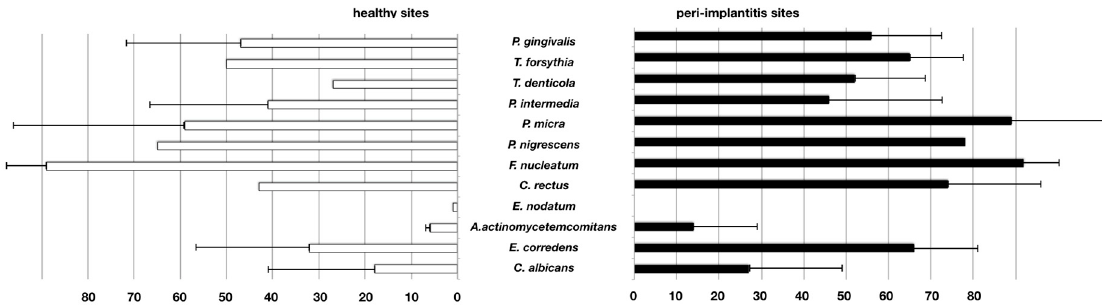
Figure 3. Frequency of positive detection in studies performing hybridization-based assessment. Weighted percentages of positive assessment in samples from healthy and peri-implantitis sites (bars = means, whiskers = standard deviation).